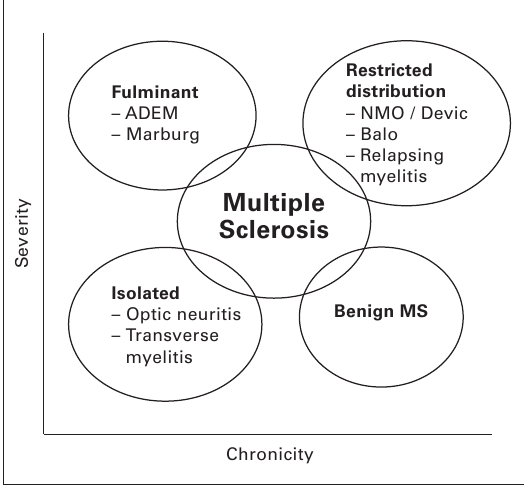
Spectrum of IDD of the CNS according to clinical observation. (Adapted from